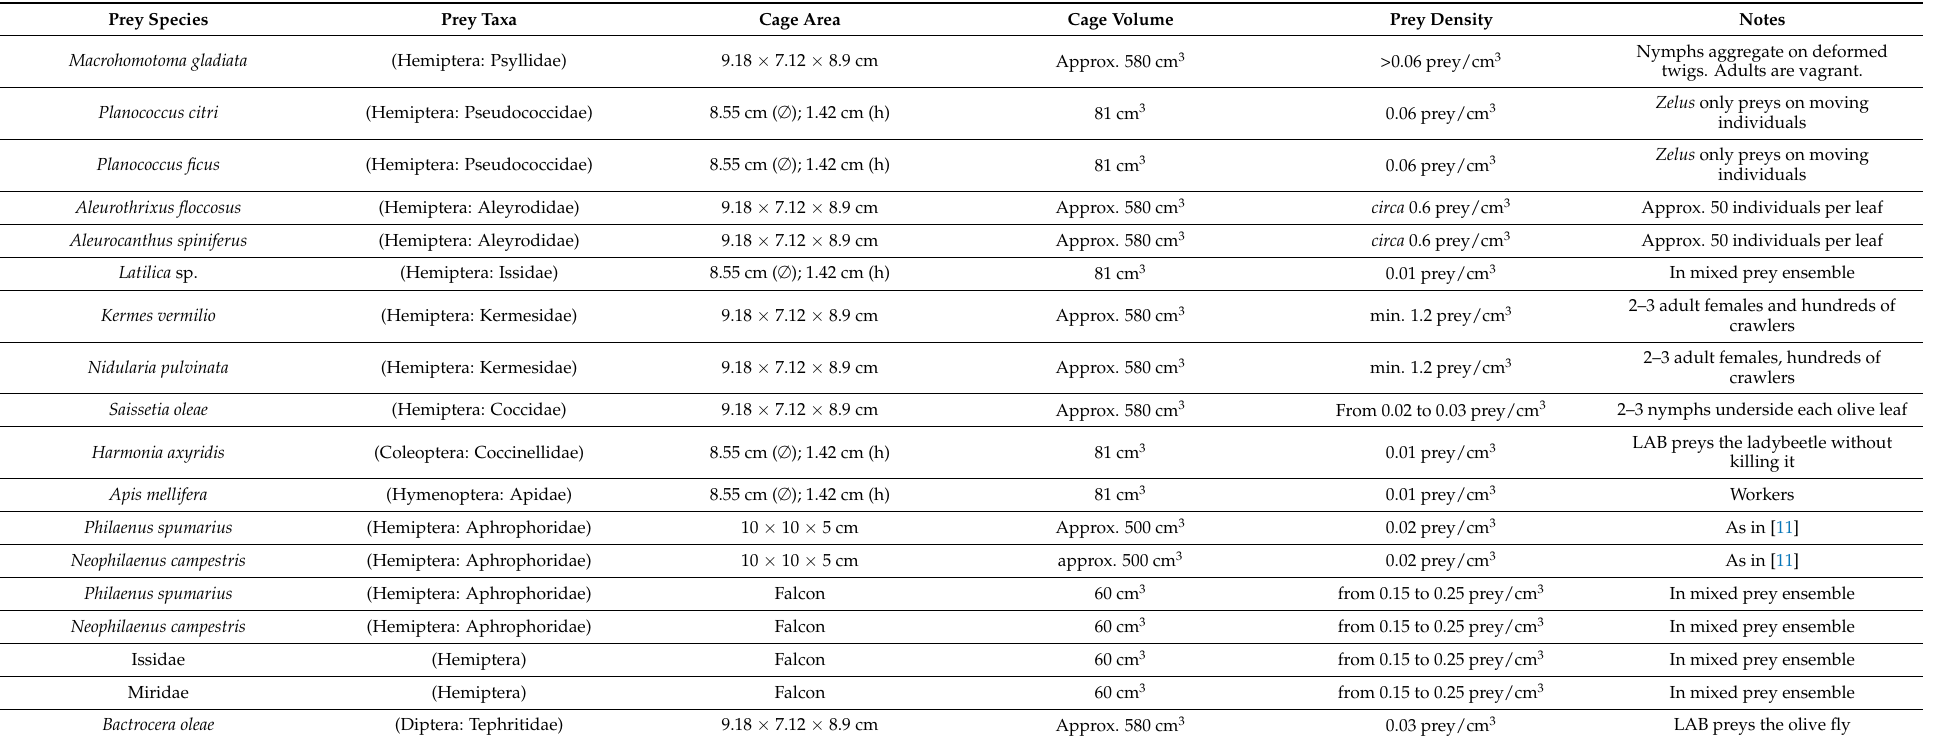
Table 2. Zelus predation test arenas